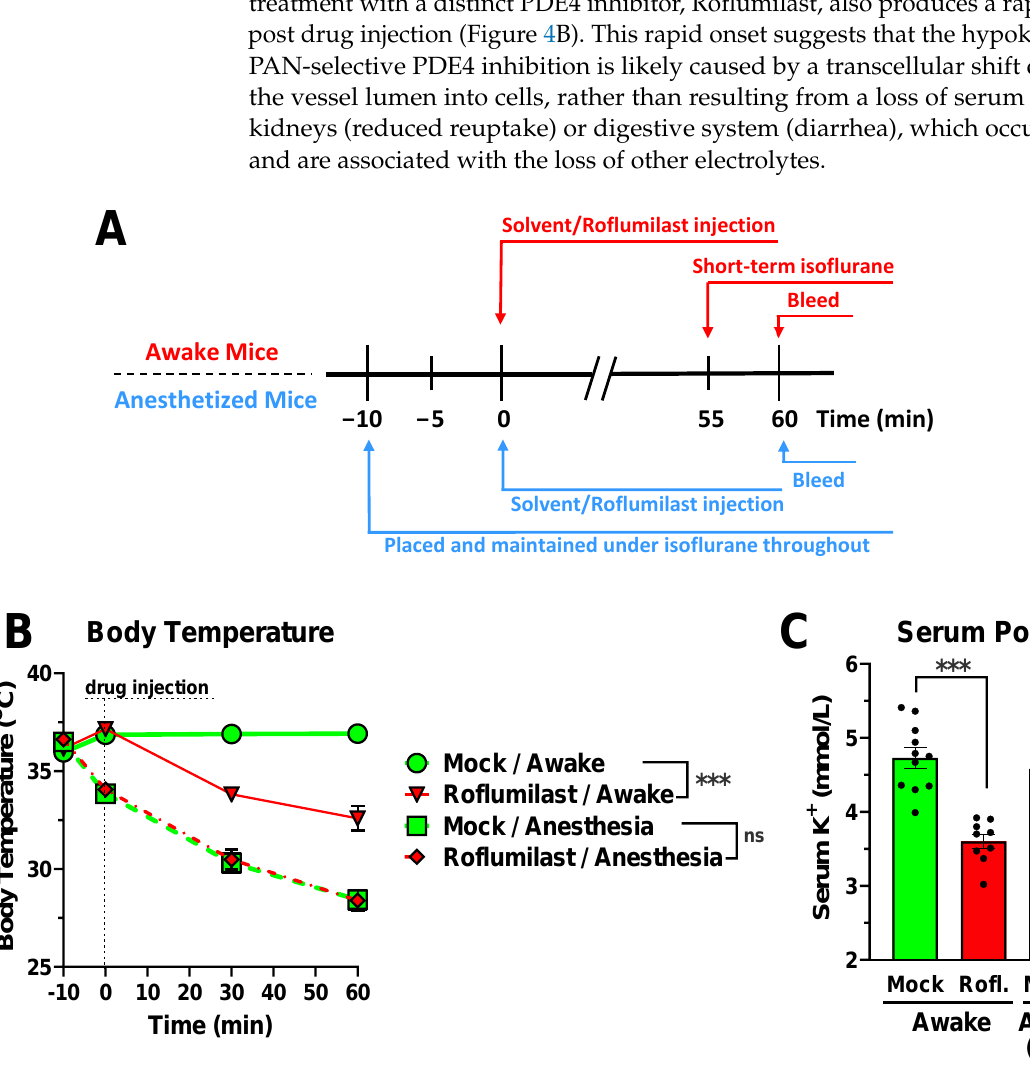
Figure 3. Reduced serum potassium levels are not caused by PDE4 inhibitor-induced hypothermia or hypokinesia. The effect of PDE4 inhibition on serum potassium levels was assessed in awake and anesthetized mice to delineate the impact of acute hypokinesia and hypothermia, which result from PAN-PDE4 inhibition in awake mice, but are abrogated under anesthesia. ( A ) Scheme illustrating experimental steps in assessing the effect of PDE4 inhibition in awake versus anesthetized mice. ( B ) Isoflurane anesthesia abrogates the hypothermic effects of PDE4 inhibition observed in awake mice. The body temperature of mice was measured using a rectal probe at the indicated times prior to and after injection of the PAN-PDE4 inhibitor Roflumilast (5 mg/kg; i.p.; n = 8) or solvent control. In awake mice (solid lines), treatment with Roflumilast (red solid line) induces hypothermia compared to solvent controls (green solid line). Conversely, Isoflurane anesthesia started at 10 min prior to PDE4 inhibitor treatment induces hypothermia by itself (green striated line), and injection of the PDE4 inhibitor Roflumilast (red striated line) produces no further effect over solvent controls. ( C ) Comparison of the effect of a 60-min treatment with the PDE4 inhibitor Roflumilast (Rofl.; 5 mg/kg; i.p.) or solvent control (Mock) on serum potassium in awake (solid bars) and anesthetized (Isoflurane, striated bars) mice. Statistical significance was determined using two-way ANOVA with Sidak’s posthoc test and is indicated as ns ( p > 0.05), and *** ( p < 0.001).